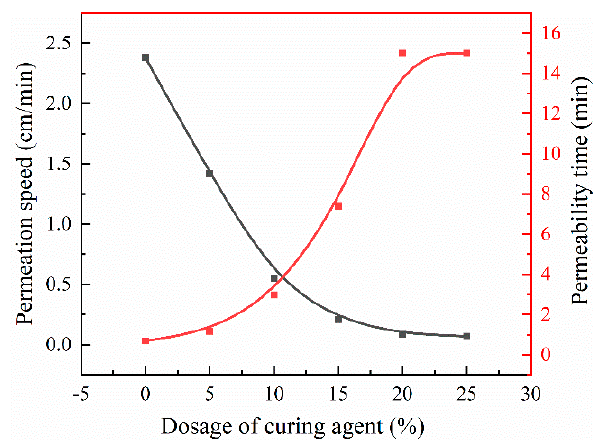
Figure 12. Relationship between curing agent dosage and penetration rate.